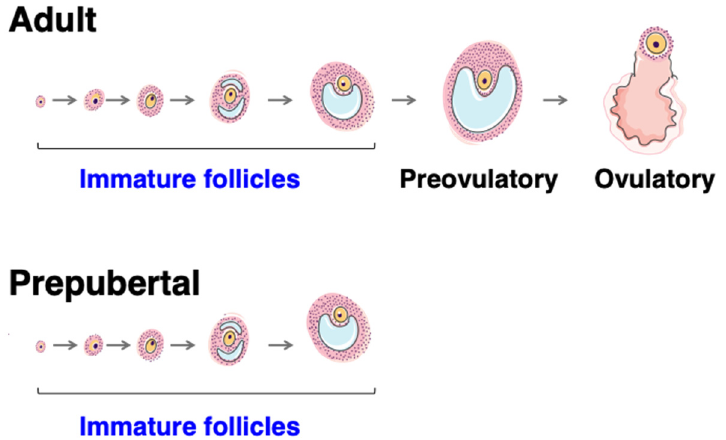
Figure 3. Different categories of follicles are present in the prepubertal ovary in mammals. The pre- pubertal ovary is endowed with growing follicles up to the antral stage, and unlike the adult ovary during reproductive life, it does not display large healthy follicles of the size of preovulatory follicles despite high gonadotropin levels during mini-puberty.